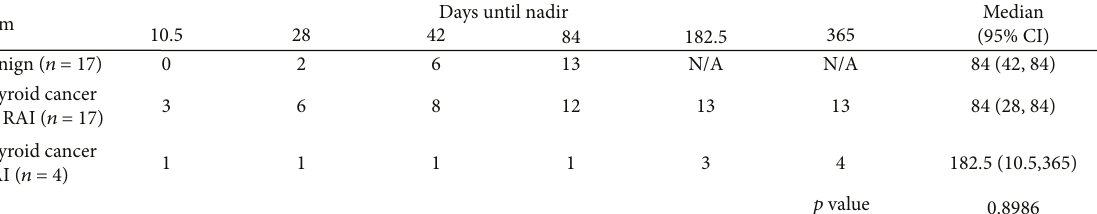
Figure 3: Cumulative number and percentage of subjects who achieved undetectable TG < 0 2 ng/mL at each time point for each